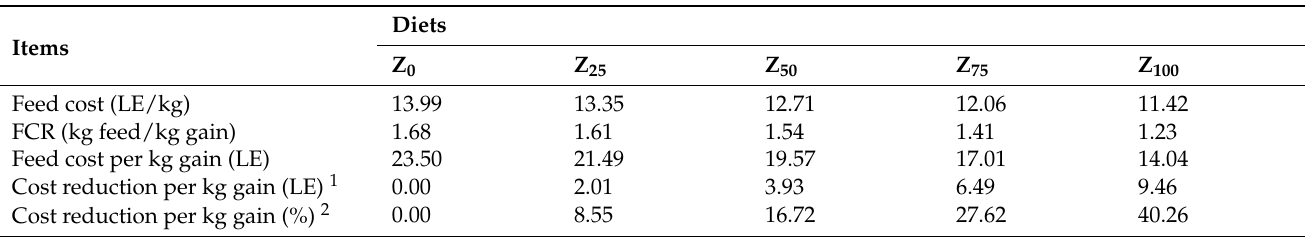
Table 6. Economic efficiency for production of 1 kg gain of grey mullet, Mugil cephalus , fed experimental diets for 60 days.